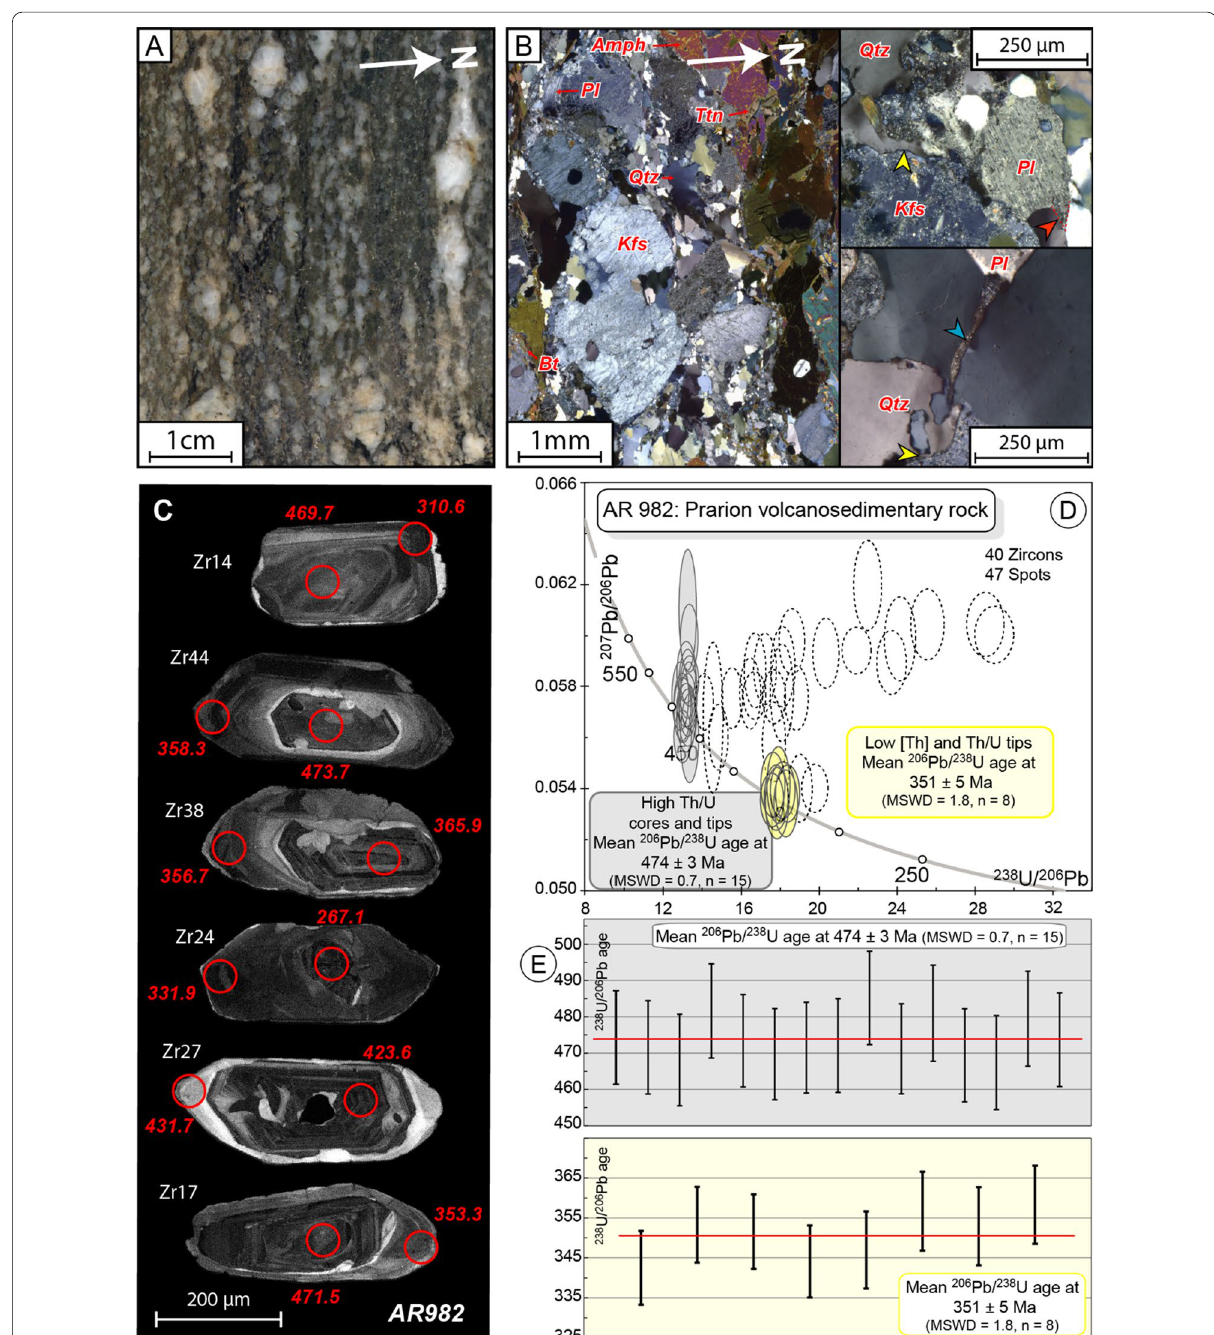
Fig. 5 Description and U–Pb LA‑ICPMS results on the Prarion metavolcano‑sedimentary rock AR982. A Photo of the sample AR982 showing distinct Kfs‑Pl‑Qtz and Amph‑rich layers. B Thin section images of the a Kfs‑Pl‑Qtz layer showing presence of small dihedral angles of interstitial phases (orange arrow), quartz filling pores (yellow arrows), and elongated interstitial plagioclases grains (blue arrow) that indicate a partial melting event (Lee et al., 2018; Stuart et al., 2018). Amph: amphibole; Bt: biotite; Kfs: K‑feldspar; Pl: plagioclase; Ttn: titanites. C Cathodoluminescence photos of zircons with locations of laser spots and associated 206 Pb/ 238 U dates. D Zircon U–Pb Tera Wasserburg diagram. Dotted ellipses are not taken into account for the calculation of the weighted average of 206 Pb/ 238 U age of the two populations (grey and yellow ellipses) because they are affected by radiogenic Pb losses and/or common Pb contaminations. Error ellipses and uncertainties in ages are 2σ. E Diagrams of the weighted average ± 206 Pb/ 238 U age of the two populations (grey and yellow). Uncertainties in dates and ages are ±